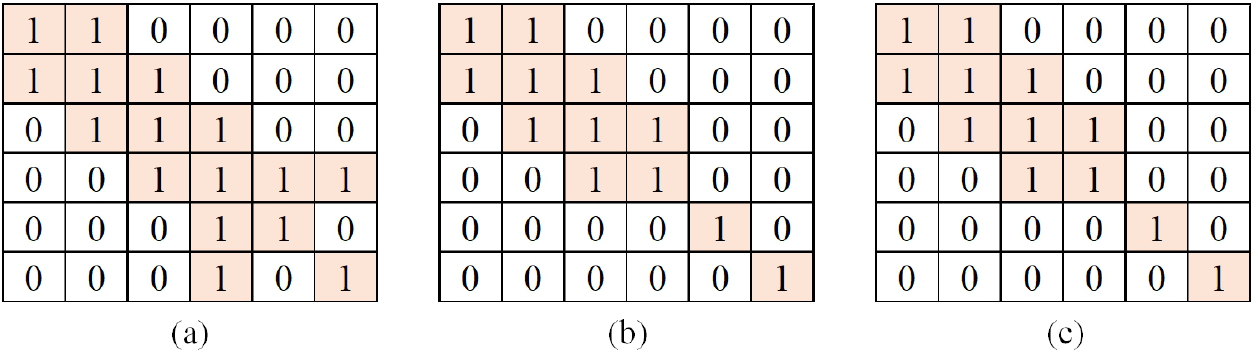
Figure 4. The designed connection between layers for the 6-bus system. ( a ) The connection between the input layer and Layer 2; ( b ) The connection between layers 2 and 3; ( c ) The connection between Layer 3 and the output